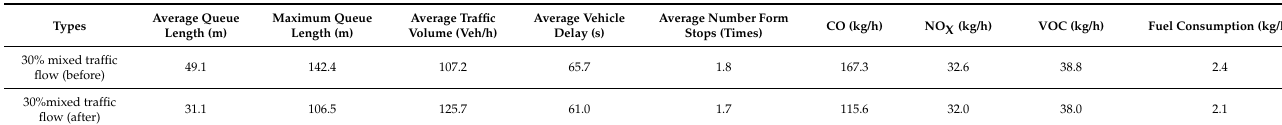
Figure 24. Comparison of parking location schemes. Table 5. Comparison results at the intersections.